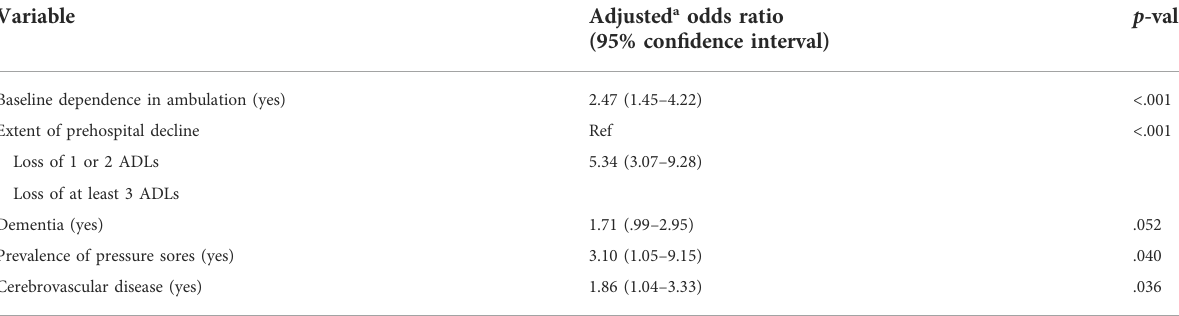
TABLE 3 Multivariate analysis of factors independently associated with in-hospital failure to recover baseline ADLs function ( n = 456).